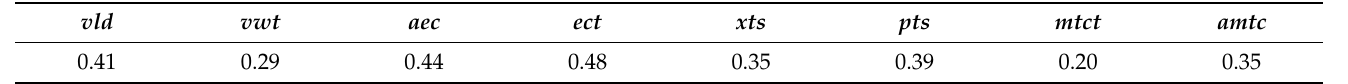
Table 2. Plasticity indices of stem structural